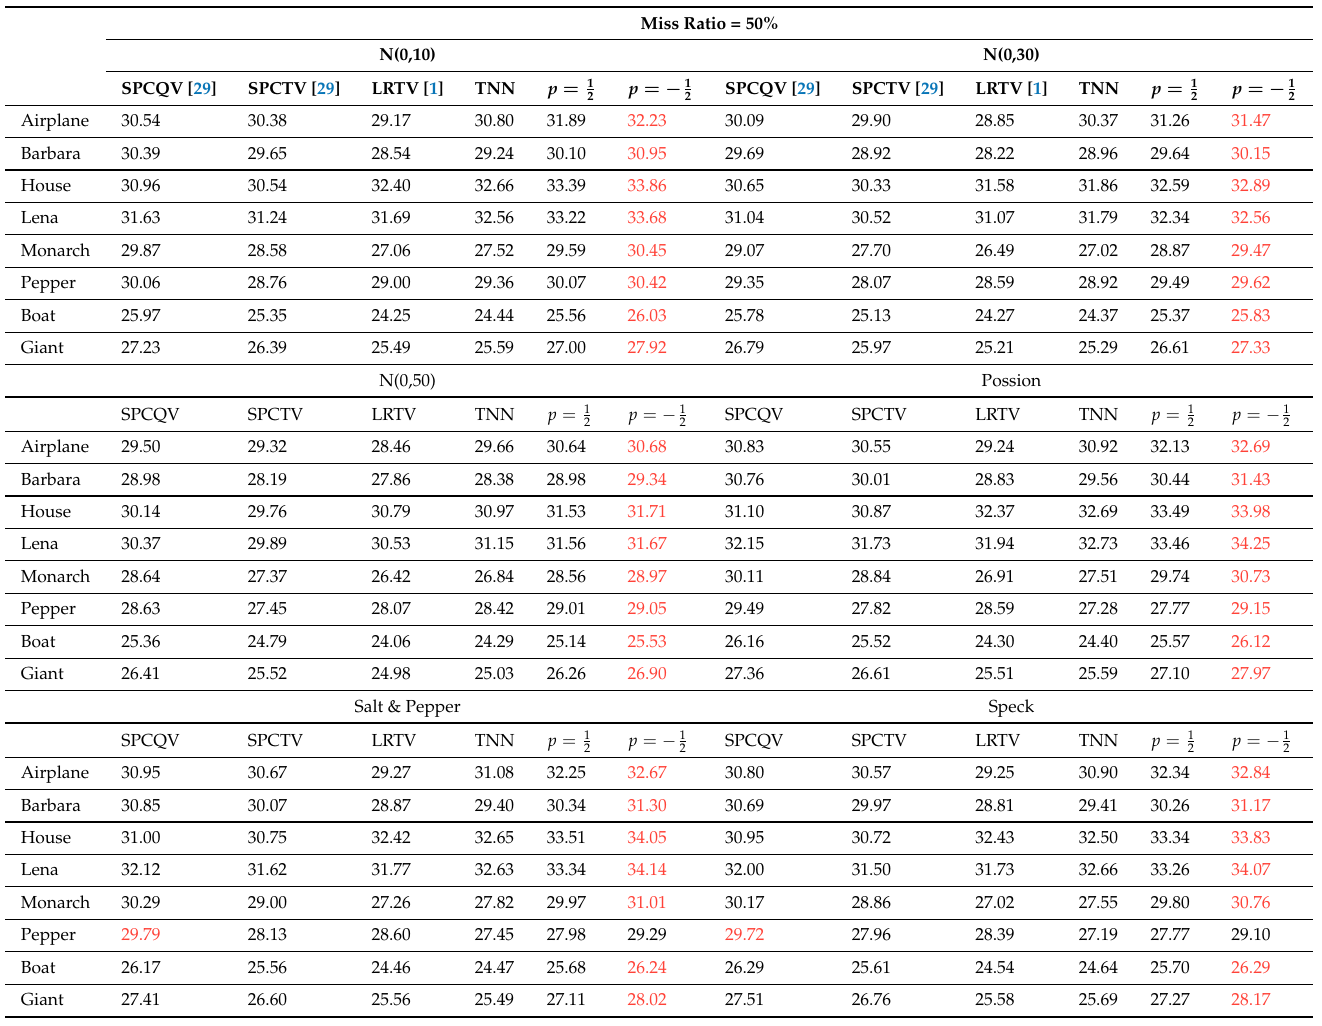
Table 3. Comparisons of PSNR for images with 50% missing elements, where red is the best result.